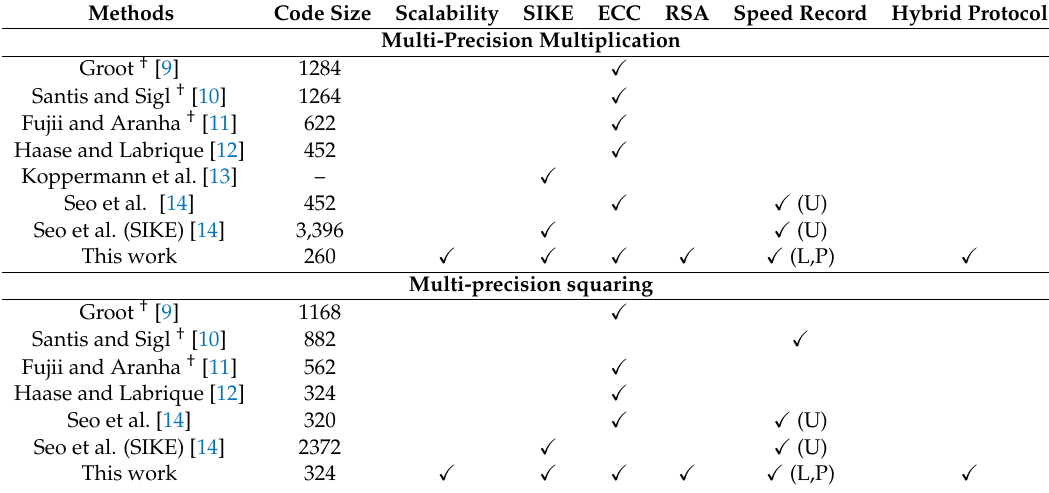
† symbol indicates implementations with fast